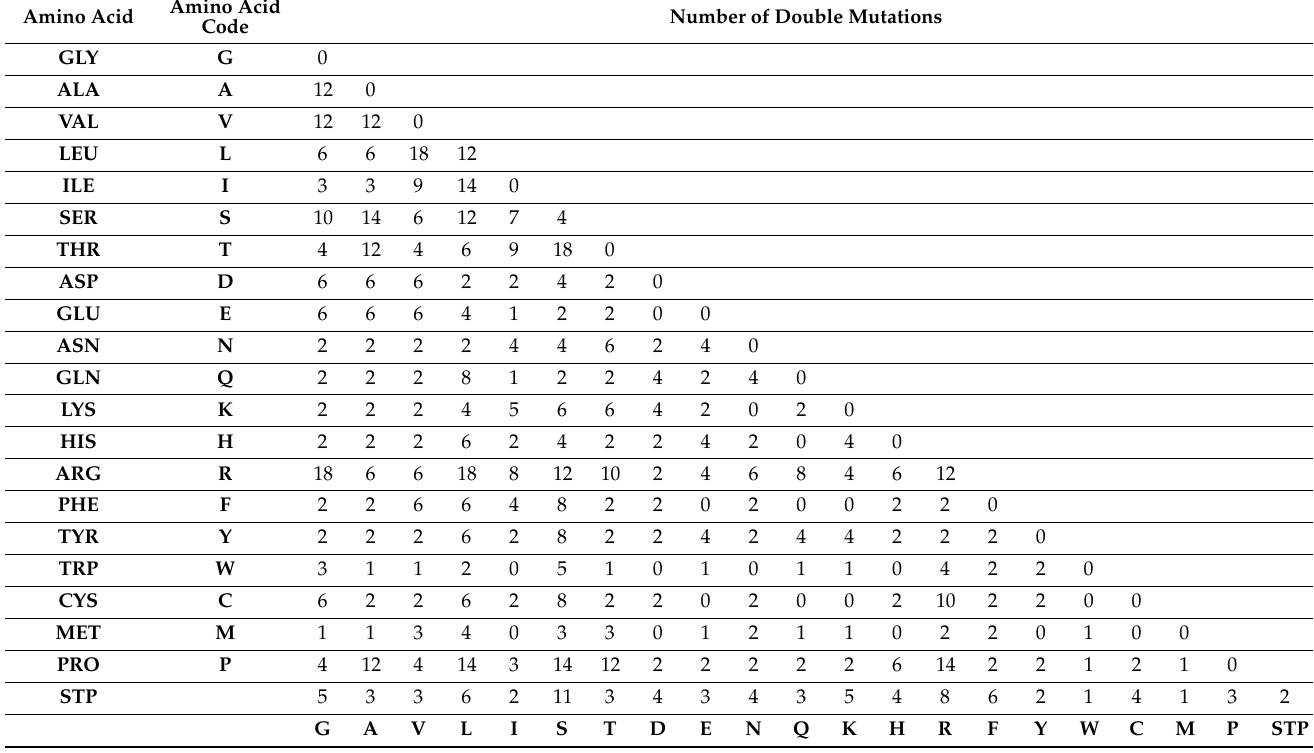
Table 3. Number of double mutations that result in each AA